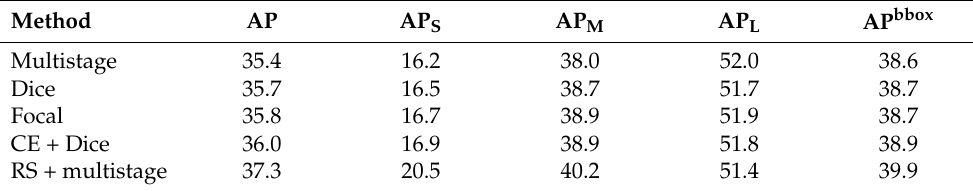
Table 5. Effectiveness of rank and sort loss function. Multistage denotes the use of a designed mask head; multistage RS and RS Mask R-CNN denotes the combination of rank and sort loss function with the multistage mask head and with the baseline, respectively. In addition, the results of Focal [16], Dice [17] and their combinations applied to the mask head are shown.